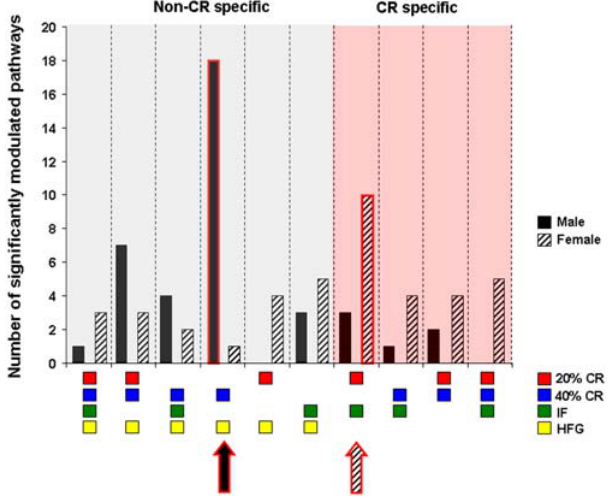
Figure 15. Significantly modulated pathways in the hippocam- pi of male and female rats in response to dietary restriction and excess. The number of pathways whose alteration overlaps between the different diets is reported. Male rats showed the largest amount of overlap between the 40% CR and HFG pathways, which suggests that their genetic response to dietary manipulation is not CR or energy specific. Female rats on the other hand, showed a significant amount of overlap between the 20% CR and IF diets, which suggests that there is a CR-dependency in genetic response to dietary manipulation in the hippocampi of female rats.